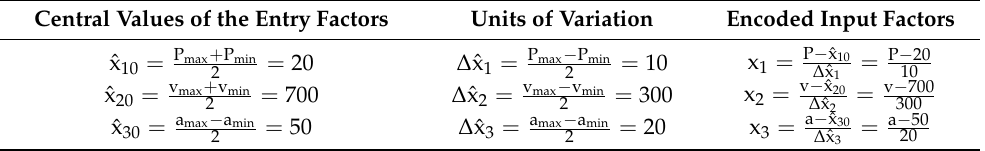
Table 1. Central values, variation units, and coding entry factors for experiment. Central Values of the Entry Factors Units of Variation